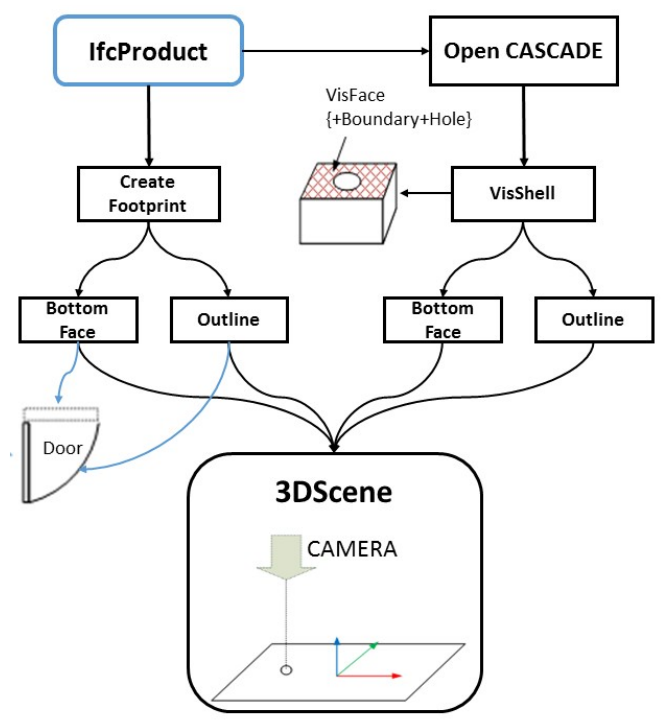
Figure 5. Fundamental algorithm to generate plan drawings.